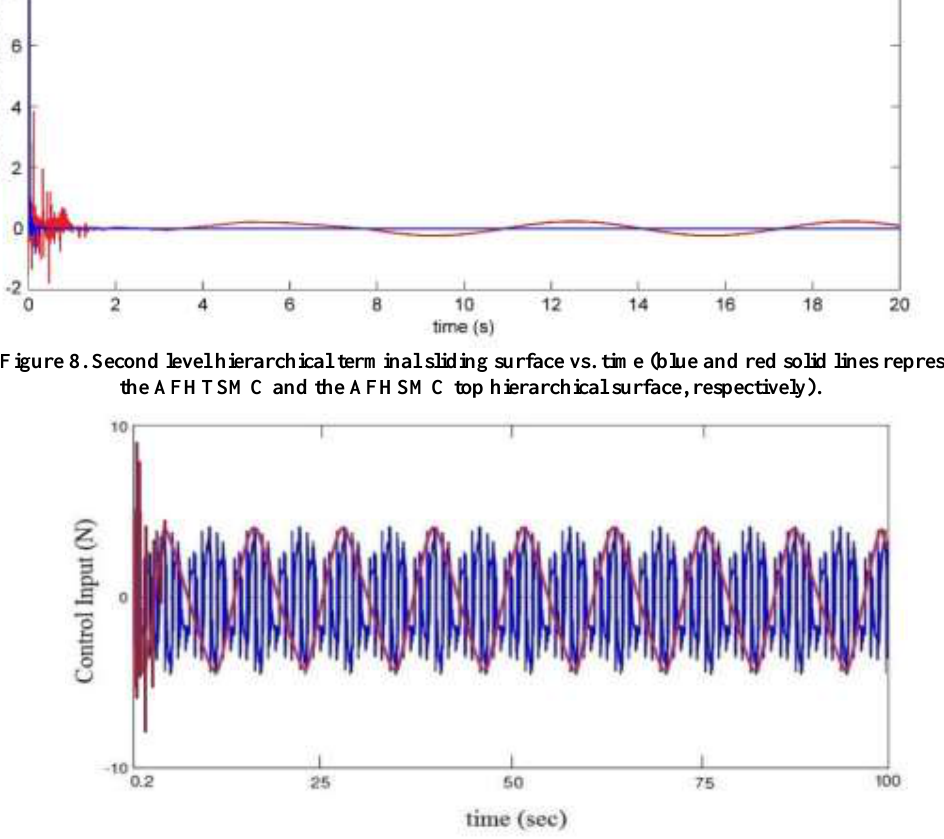
Figure 9. The control input (u) vs. time (The blue solid line and the red solid line show the force values for AFHTSMC and AFHSMC,